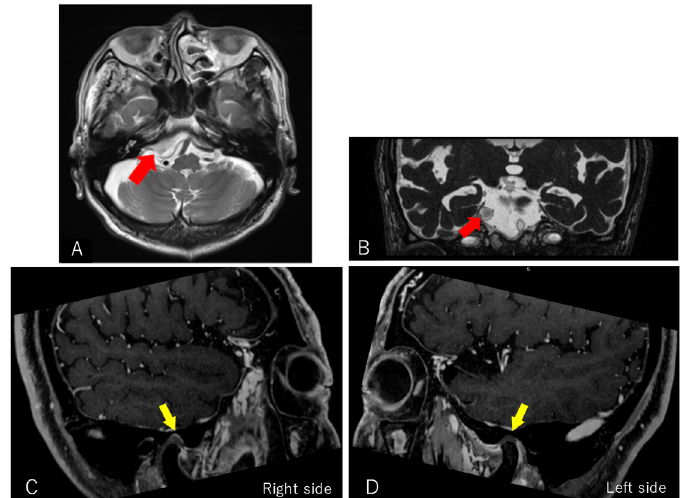
Figure 5. Axial ( A ) and coronal ( B ) T2-weighted magnetic resonance imaging showing a heteroge- neously enhanced mass (red arrow). Reconstructed MR images showing no abnormal structure of the TMJ components. ( C , D ) The articular disc (yellow arrow) is in a correct position.